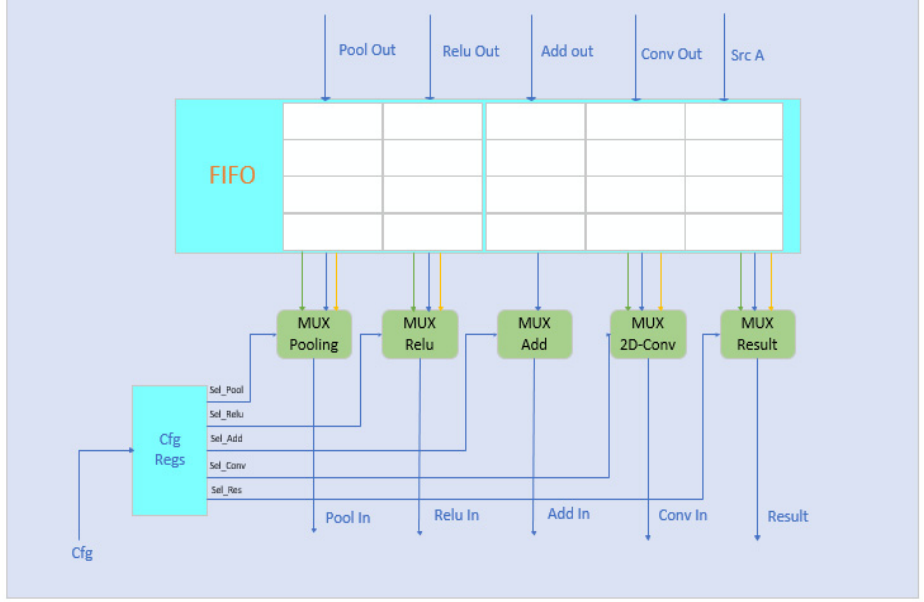
Figure 9. Structure of the pooling circuit.